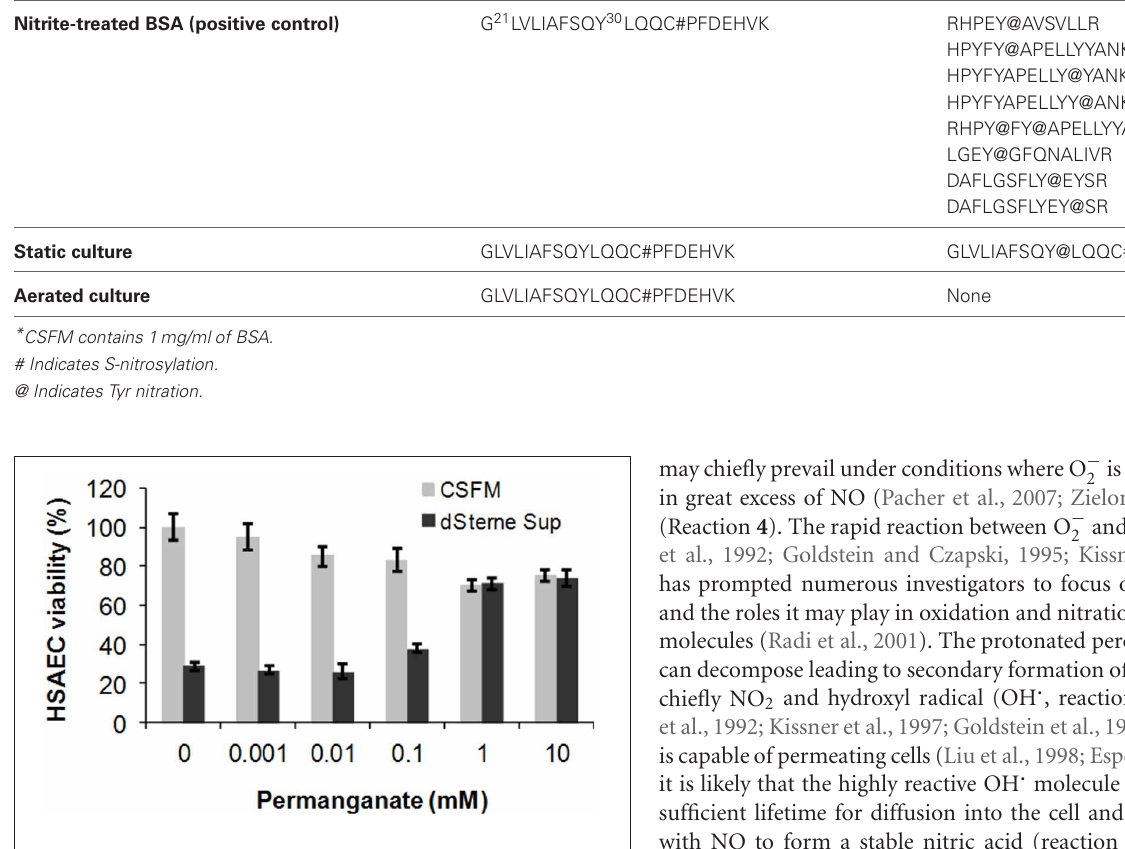
biological species including sulfhydryl compounds (Wink et